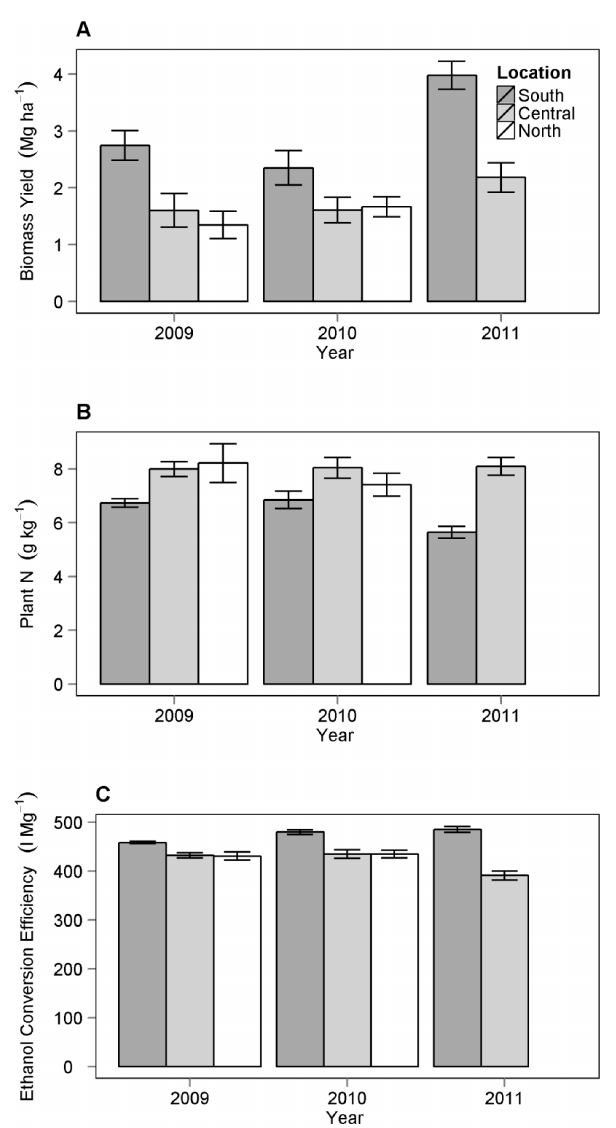
Figure 2. Average values (SE) of response variables by location and year. Mean values of biomass yield (A), plant tissue N (B), and ethanol conversion efficiency (C). Black, gray and white bars are mean values from plots harvested in south, central and north locations respectively. doi:10.1371/journal.pone.0061209.g002 (Table 4). The best supported model included an interaction term between location and legume cover (Table 5). In the south, legume cover was negatively correlated with plant N as opposed to the positive correlation observed in the central and north locations (Figure 5A). Soil N–NO 3 and C4 cover were positively and negatively correlated with plant N respectively (Table 5). The best fitting random structure for modeling the concentration of N in biomass included PLOT nested within BLOCK. This structure was superior to a model without a random component (L = 14.9, df = 1, P , 0.001) and to a model with a fully nested hierarchy of random variables (L =9.2, df = 1, P= 0.003).